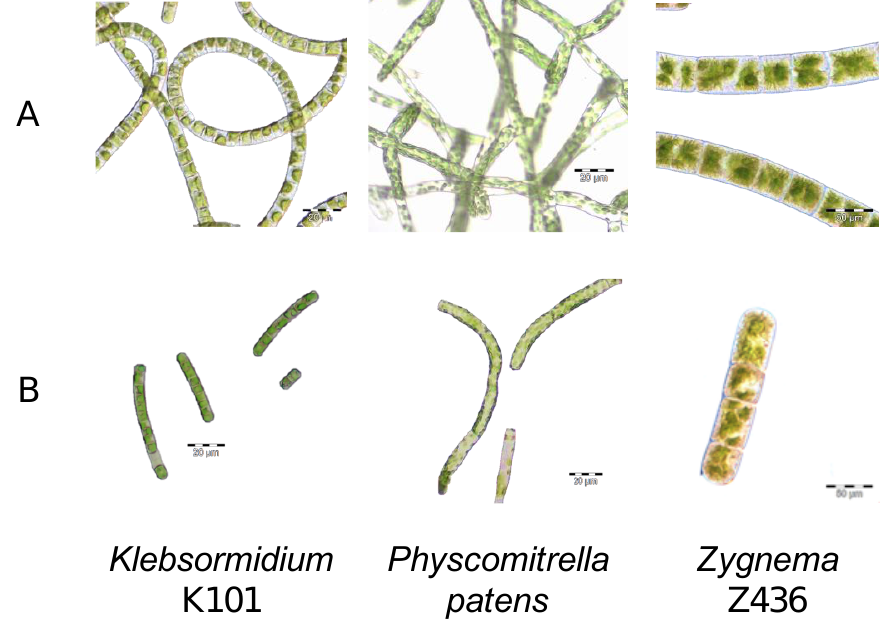
Figure 1. Fragmentation of the algae Klebsormidium flaccidum K10, Zygnema sp. Z436 and of the moss Physcomitrella patens . Regularly growing algae and moss on plates ( A ) were sheared to smaller fragments of app. 2 – 7 cells in length ( B ).